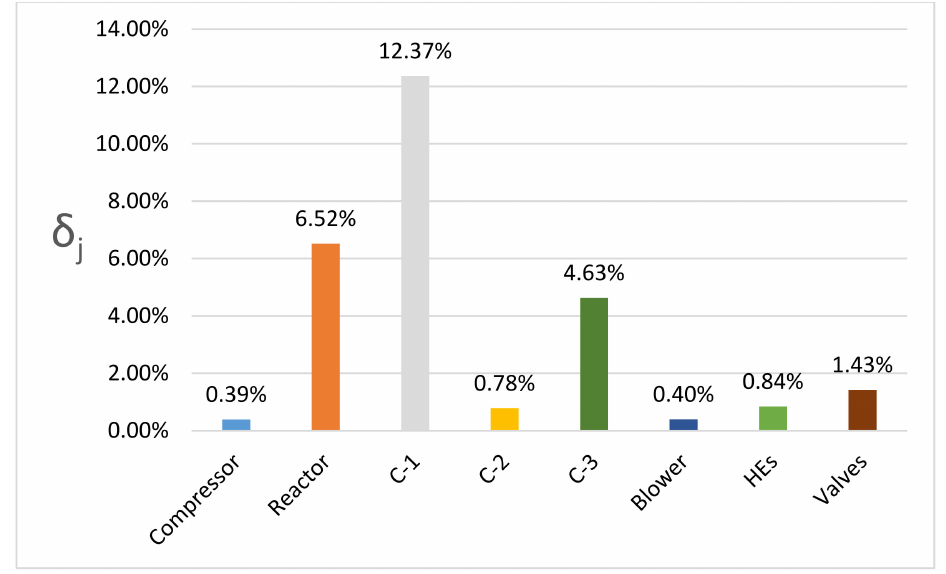
Figure 7. Percentage of fuel exergy ( E F = 150.13 MW) destroyed per